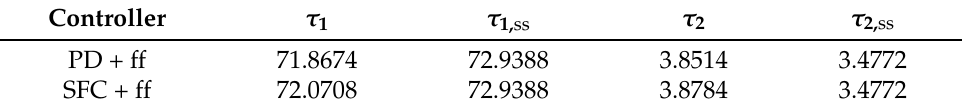
Table 3. Root Mean Square (RMS) of applied torques comparative of the simulations without F C . Controller